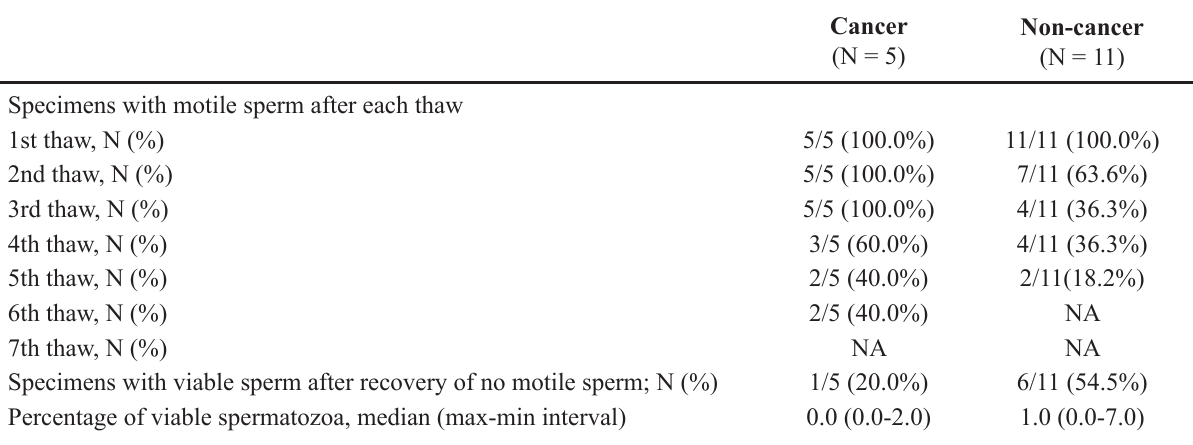
Table 5 – Frequency of recovery of motile spermatozoa after each thaw in specimens from patients with and without cancer, and percentage of viable spermatozoa after recovery of no motile